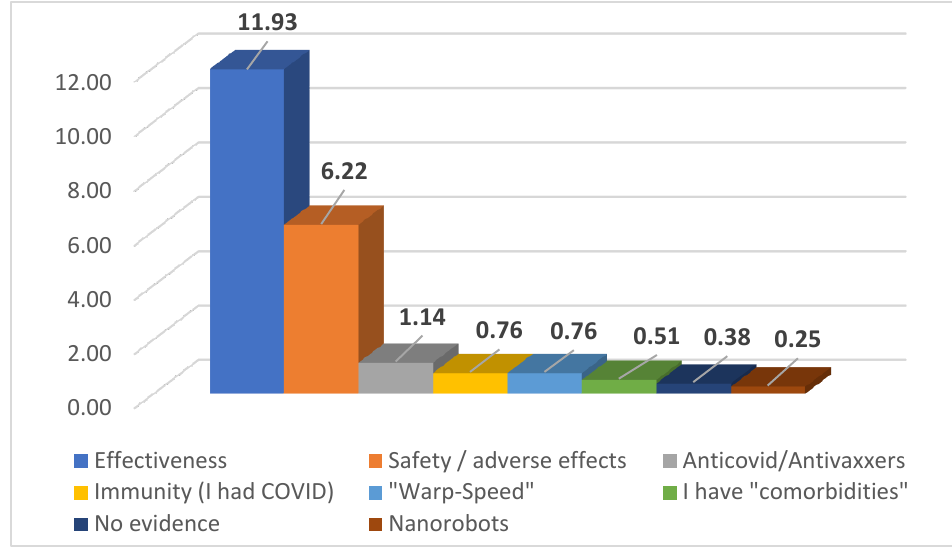
Figure 1. Main reasons for not wanting to get vaccinated (global) in percentage.